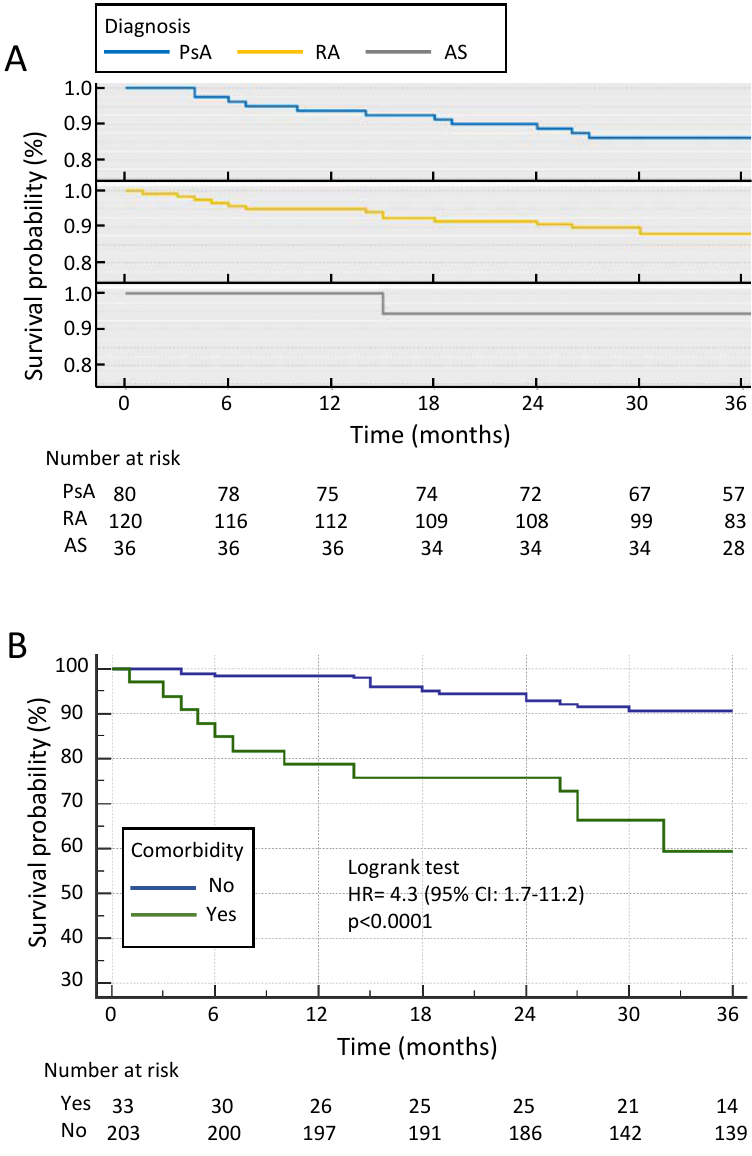
Figure 1. Kaplan–Meier curve showing retention rate in RA, PsA and AS patients over 3 years treated with SB4 after ETA failure. ( A ) Cumulative retention probability in RA, PsA and AS patients; ( B ) retention rate in all patients with and without comorbidity. AS = ankylosing spondylitis; ETA = etanercept; PsA = psoriatic arthritis; RA = rheumatoid arthritis.